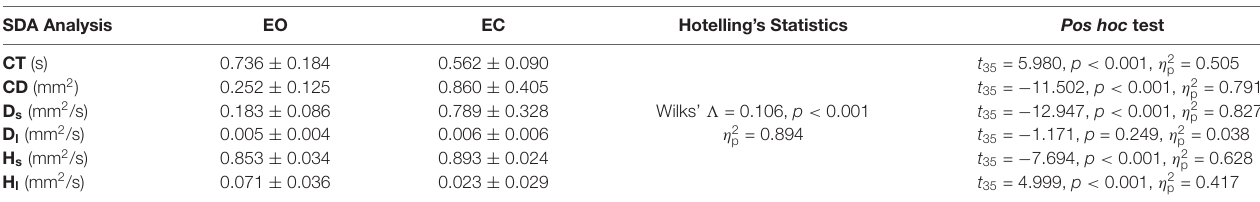
TABLE 3 | The contrast population means of variables of stabilogram diffusion analysis (SDA) between the eyes-open (EO) and eyes-closed (EC)